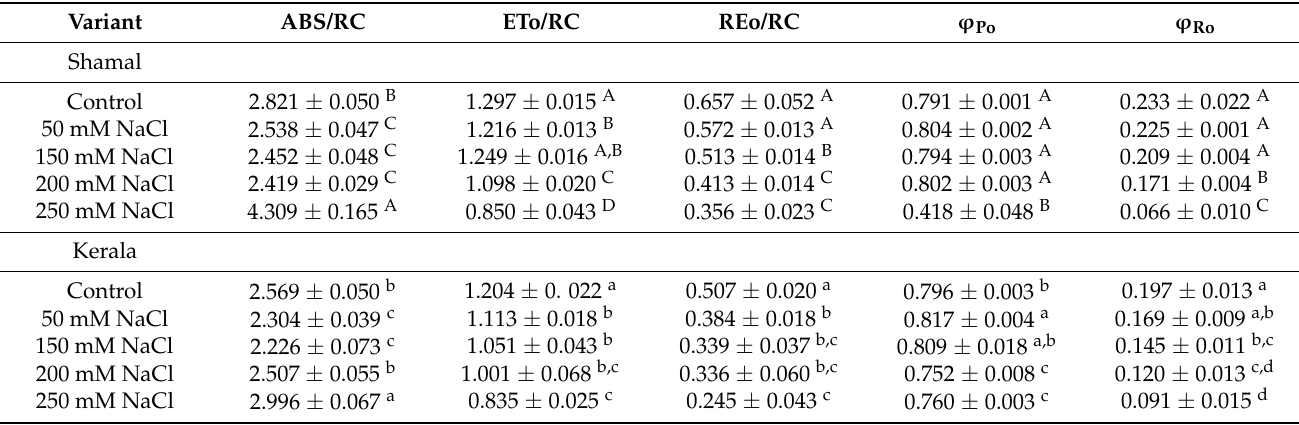
Table 2. Effects of different NaCl concentrations on the OJIP parameters in leaves of sorghum ( Sorghum bicolor L. Shamal) and maize ( Zea mays L. Kerala).